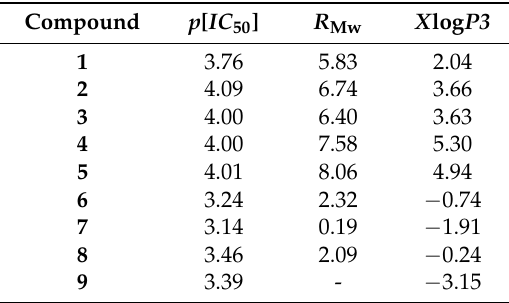
Table 2. Antiviral activity and lipophilicity parameters of 2-deoxy sugar derivatives of uridine.